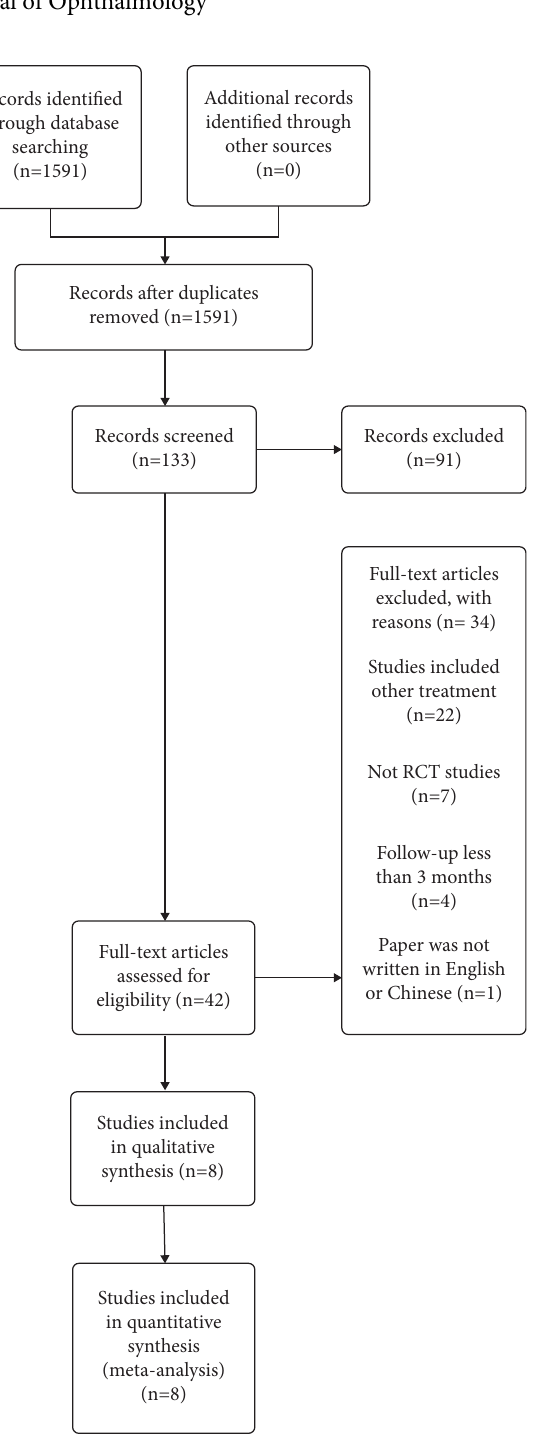
Figure 1: Te study fow